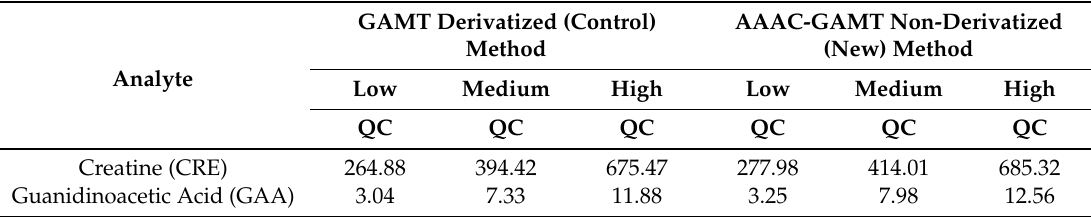
Table 1. Creatine and guanidinoacetic acid group means comparisons using low, medium, and high GAMT QC pools. Units: µ M blood.